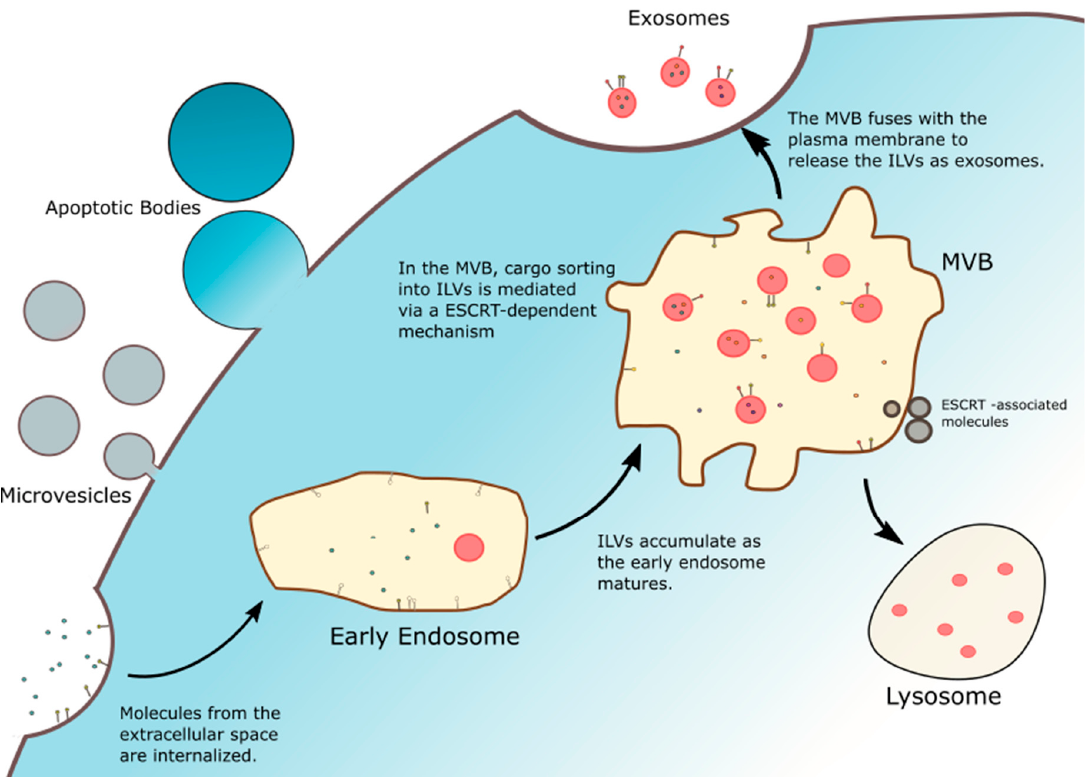
Figure 1. Biogenesis of extracellular vesicles. Microvesicles and apoptotic bodies originate directly from the plasma membrane, while exosomes are derived from the endosomal compartments. intraluminal vesicles (ILVs) accumulate in the multivesicular bodies (MVBs) after early endosome maturation. Proteins, lipids, nucleic acids and other cargo are sequestered within the ILVs through an endosomal sorting complex required for transport (ESCRT)-dependent pathway. Eventually, MVBs fuse with the plasma membrane and release the ILVs into the extracellular space as exosomes.